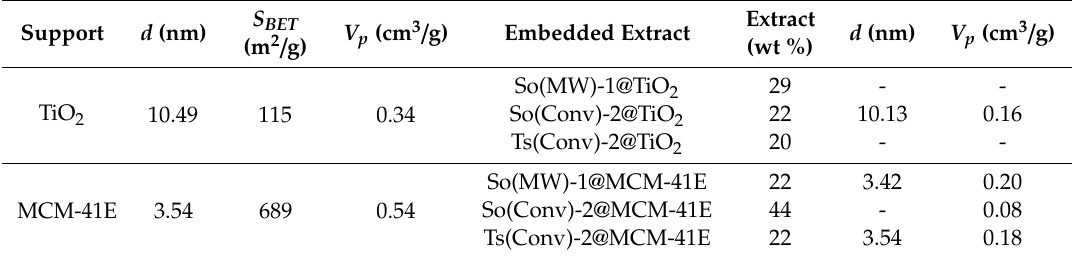
Table 5. Textural features for supports and materials containing embedded